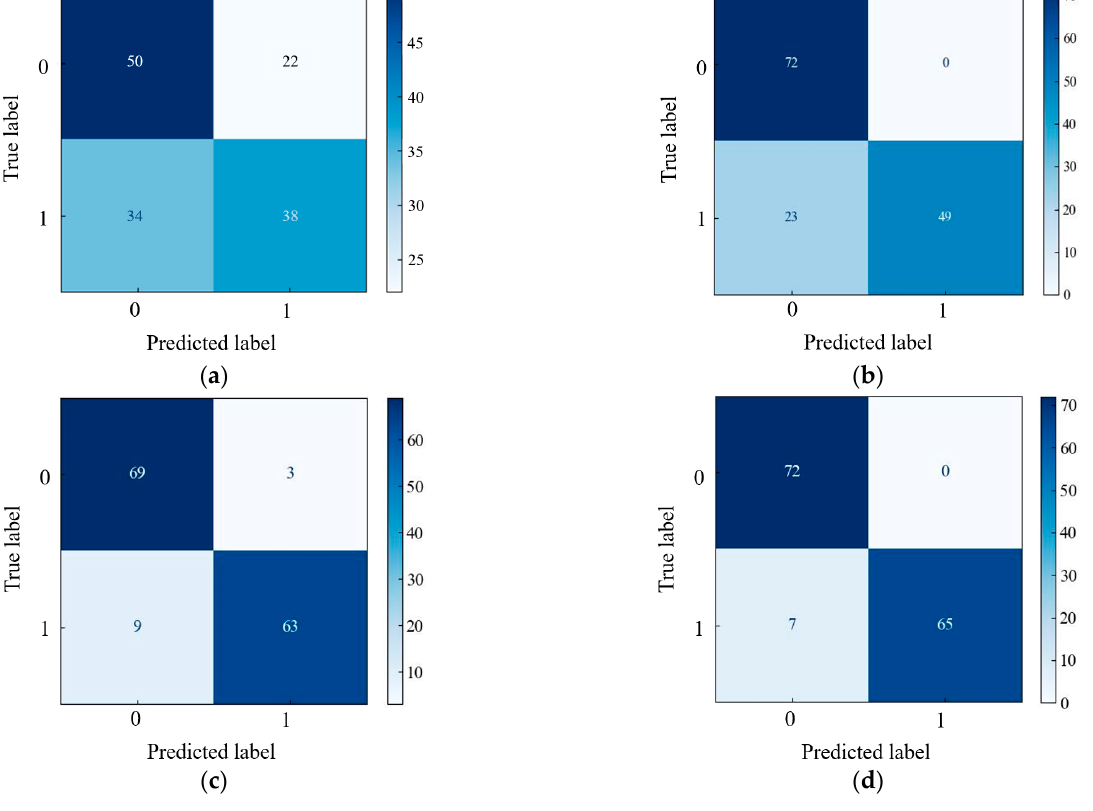
Figure 11. Accuracy confusion matrix for different models in the prediction set of the four